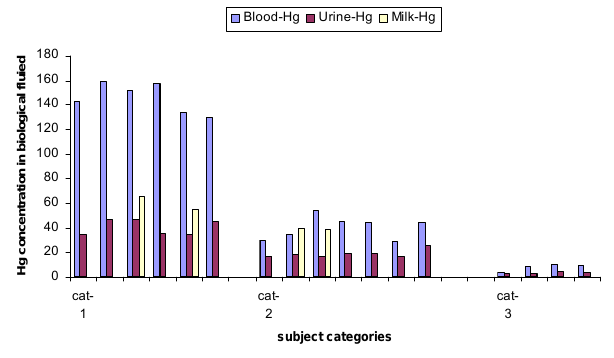
Fig. 6. Mercury levels (µgL − 1 ) in selected biomarkers of identified Fig. 06: Mercury levels (µg L -1 ) in selected biomarkers of identified subject categories around an integrated steel plant. subject categories around an integrated steel plant